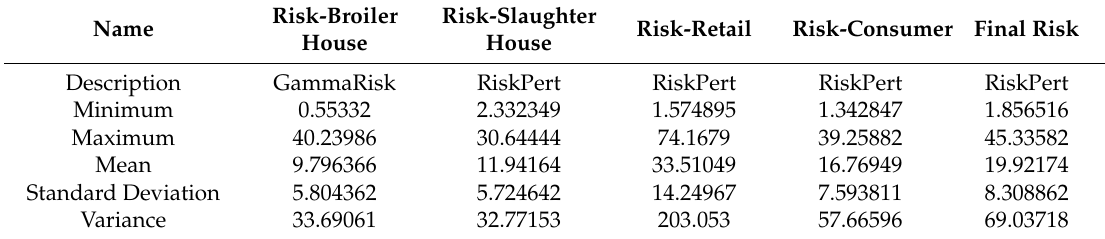
Table 2. Results of risk assessment model for Salmonella in broiler